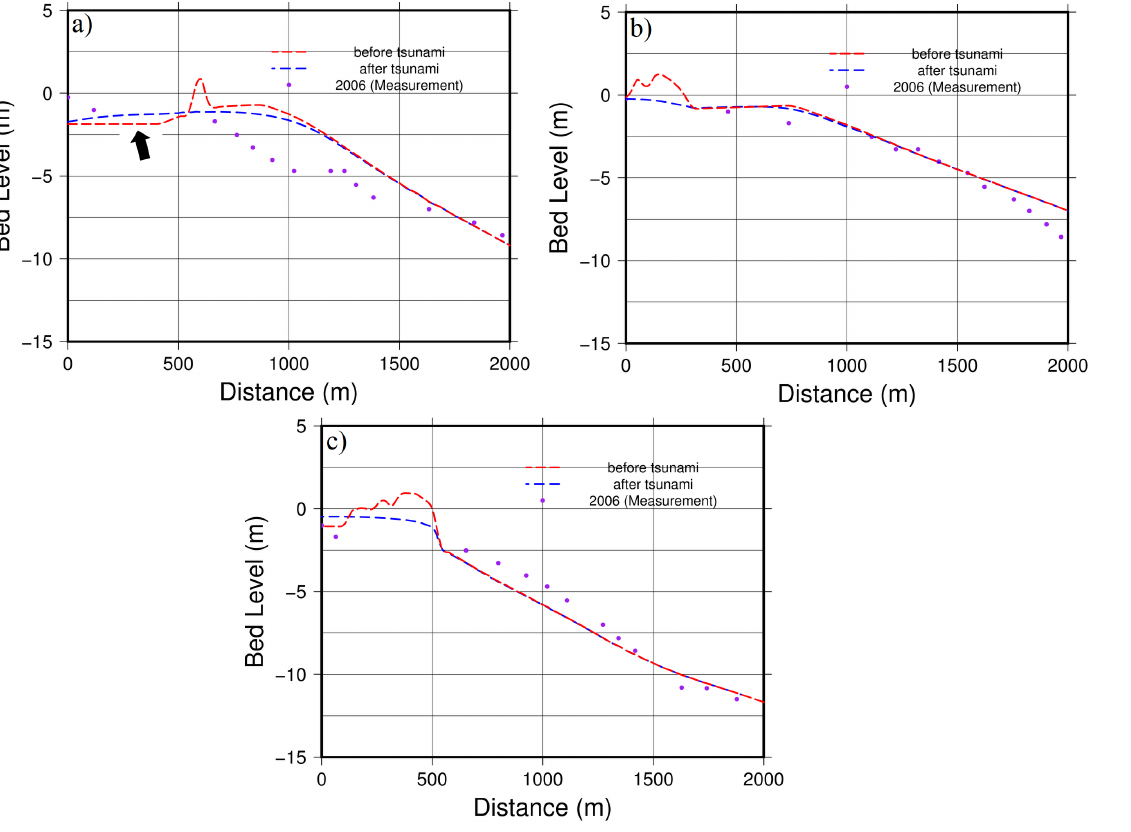
Figure 9. Bed profile for the initial condition (indicated by red line), after tsunami inundation (simulation) by the 2004 Indian Ocean Tsunami (indicated by blue line), and measured in 2006 (indicated by pink-solid circles) in the cross-section; ( a ) I-I, ( b ) II-II and ( c )